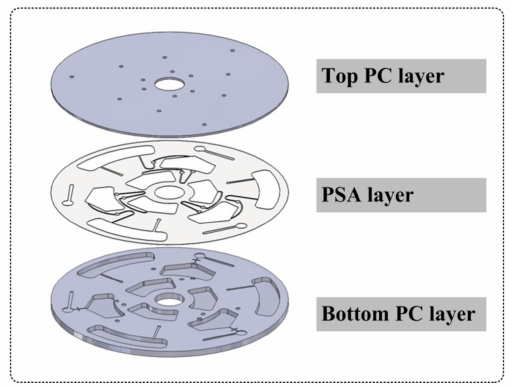
Figure 1. 3D rendering of the three-layer structure of the centrifugal microfluidic disc.